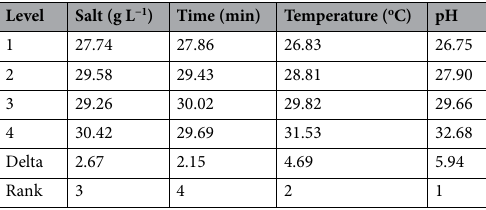
Table 8. Response table for S/N ratios in T% of B194 dyeings.